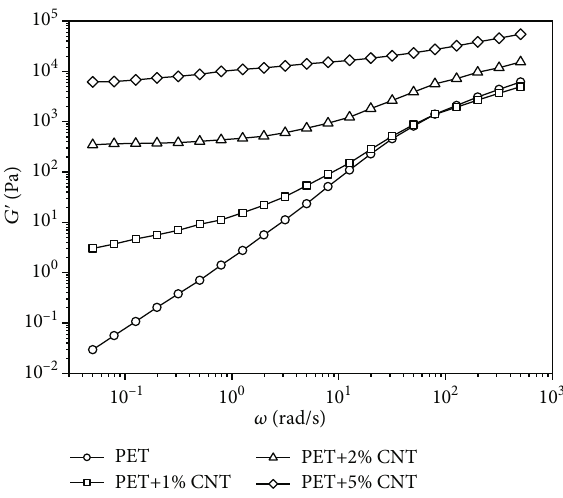
Figure 6: PET/CNT nanocomposite storage modulus G ′ ð ω Þ curves.